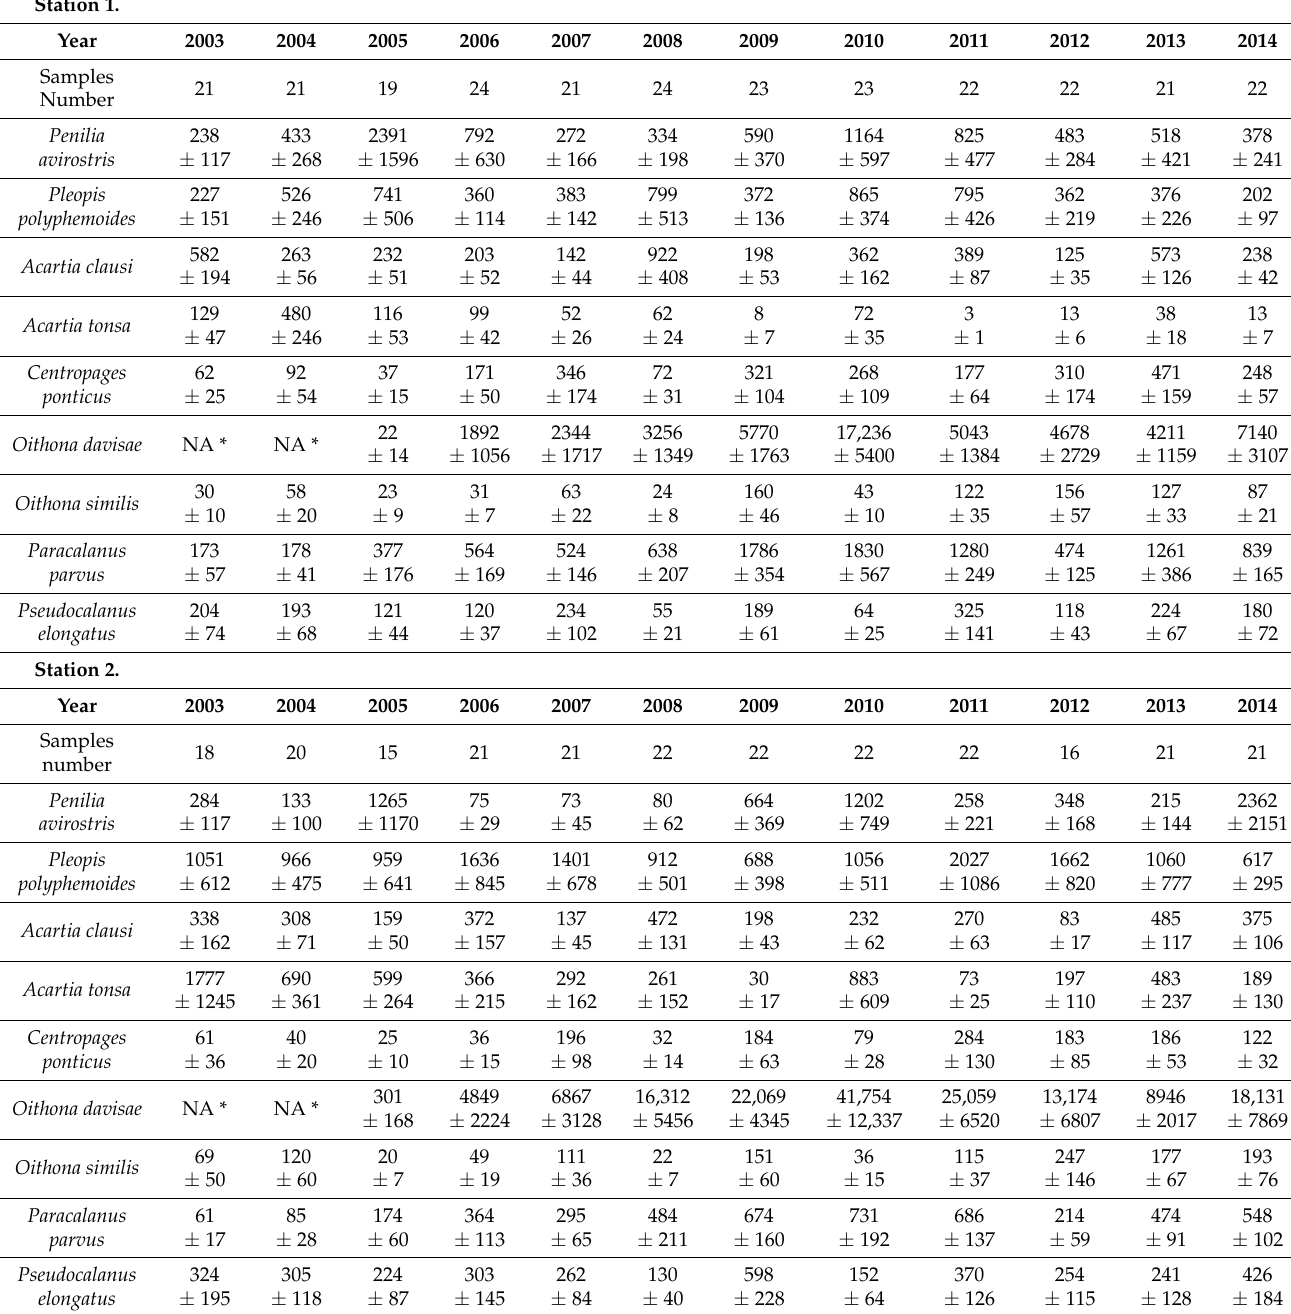
Table 1. Interannual variations in abundance of the numerous crustaceans (ind. m − 3 ± standart error) at the mouth of Sevastopol Bay (station 1) and in the middle of the bay (station 2). Station